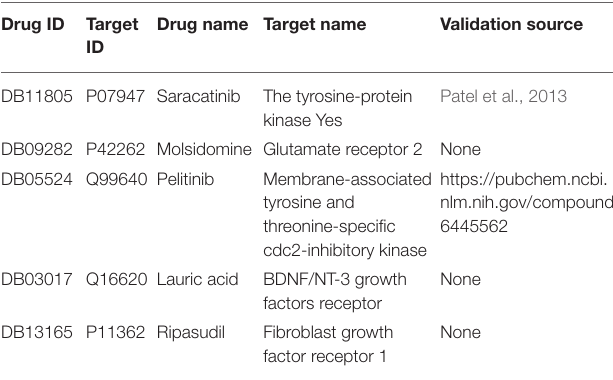
TABLE 5 | Top five novel DTIs predicted by SPVec-GBDT. Drug ID Target